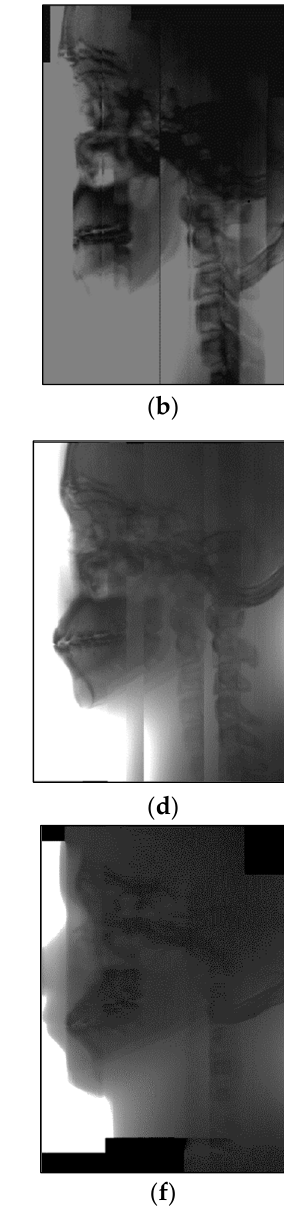
Figure 15. Stitching process of lateral cephalogram. ( a ) The image sequence is stitched in multiple rounds, ( b ) results of anterior skull stitching, ( c ) results of posterior skull stitching.